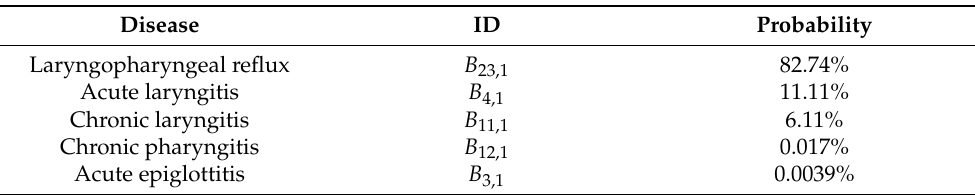
Table 3. The diagnostic result of DUCG basing on the patient’s current symptoms and physical signs.